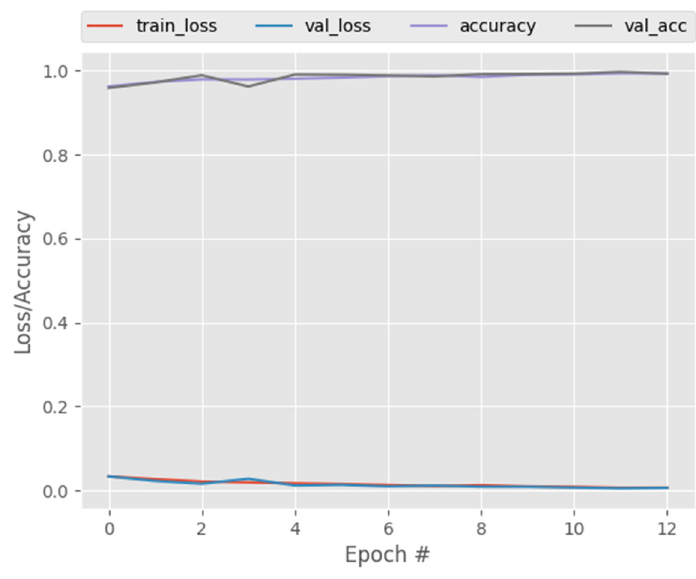
Figure 6. CNN training and validation performance.